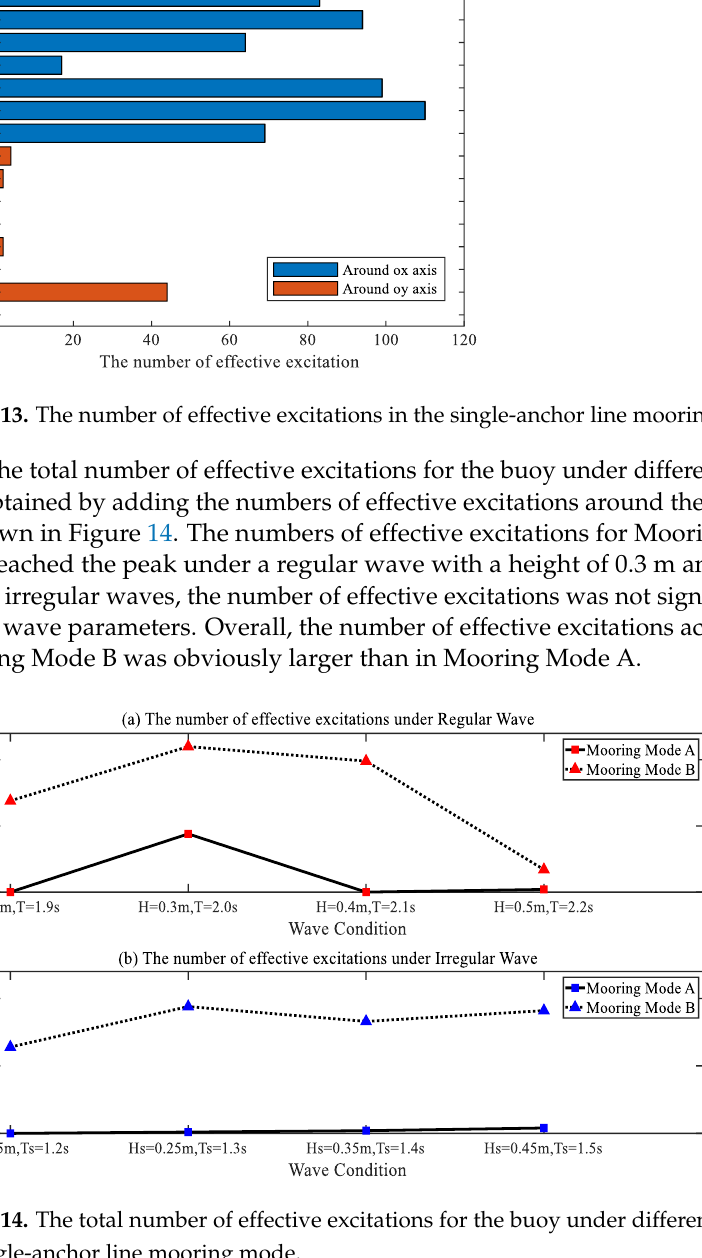
mode obtained from experiments is shown in Figure